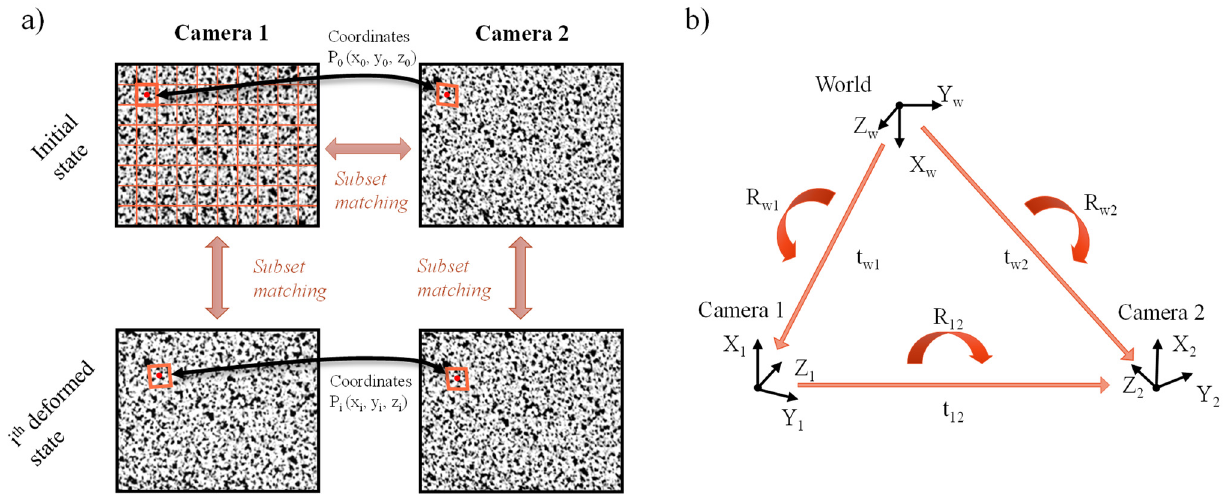
Figure 3. ( a ) Image correlation procedure for subset matching in stereoscopic measurements. ( b ) Translational and rotational transformations of the coordinate systems employed for 3D-DIC.